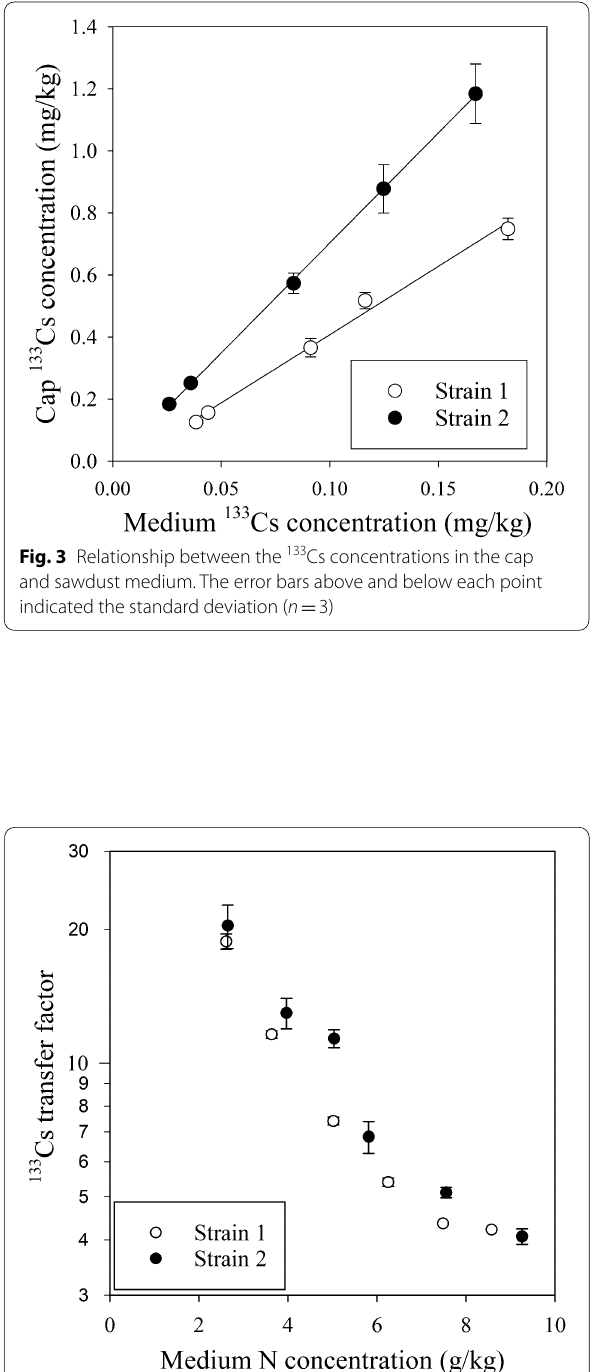
Table 2 Relationships between to 133 Cs TF period, cap yield, and cap number for Strain 1 and 2 Strain Cultivation Fig. 4 Relationship between the 133 Cs transfer factor and the N concentration in the sawdust medium. The 133 Cs transfer factor was based on the sawdust medium Cs concentration after fruiting body development. The error bars above and below each point indicated the standard deviation. n 1 at an N concentration of 8.6 g/kg (rice = bran addition rate 30%) for Strain 1; n 2 at an N concentration of = = 5.0 g/kg (rice bran addition rate 15%) for Strain 2; and n 3 for all = = other points